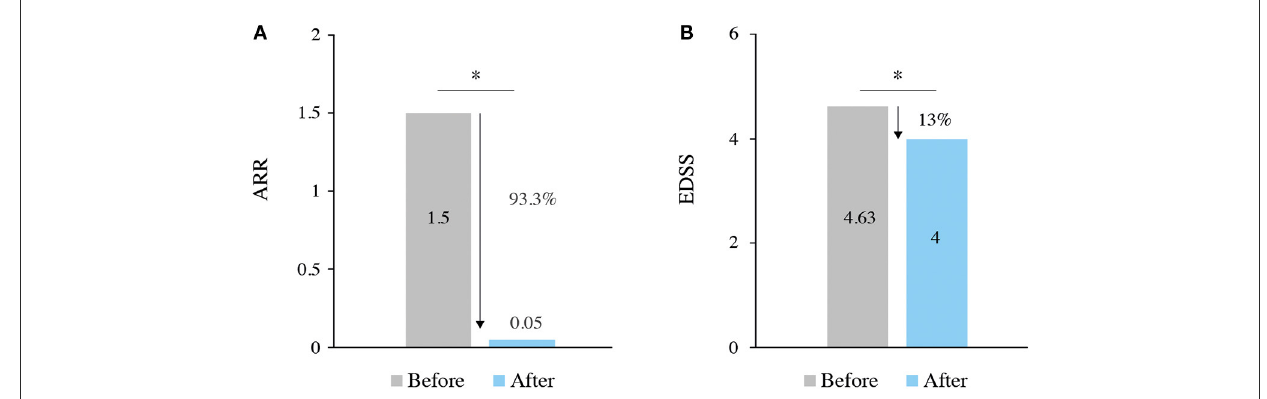
MRI data of Gd + T1 lesions and T2 hyperintense lesions were available for 119 and 120 patients, respectively. The mean number of Gd + T1 lesions was significantly reduced (1.7 before vs.